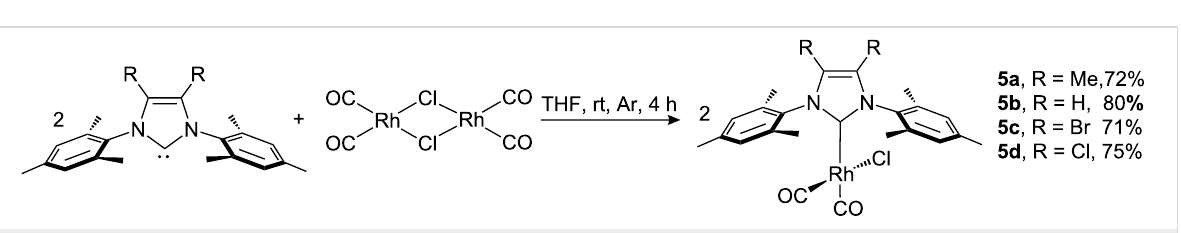
Scheme 2: Synthesis of [RhCl(CO) 2 (NHC)] complexes.